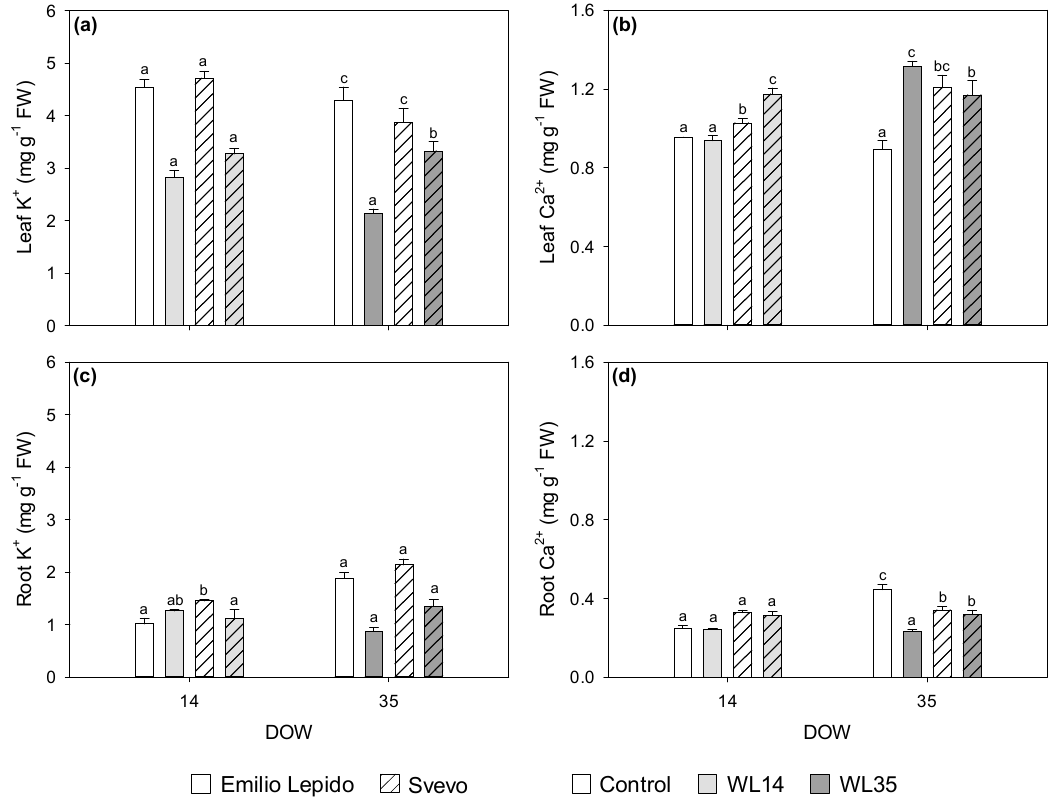
Figure 6. ( a ) Leaf K + ( b ), leaf Ca 2+ ( c ), root K + , and ( d ) root Ca 2+ content of the durum wheat cultivars Emilio Lepido (solid) and Svevo (pattern) subjected to 0 (i.e., control; white), 14 (i.e., WL14; light gray), or 35 (i.e., WL35; dark gray) days of waterlogging (DOW). Data are mean ± standard deviation. FW: fresh weight. For each waterlogging duration, according to Tukey’s post hoc test ( p ≤ 0.05), different letters indicate significant differences among means ( p ≤ 0.05).